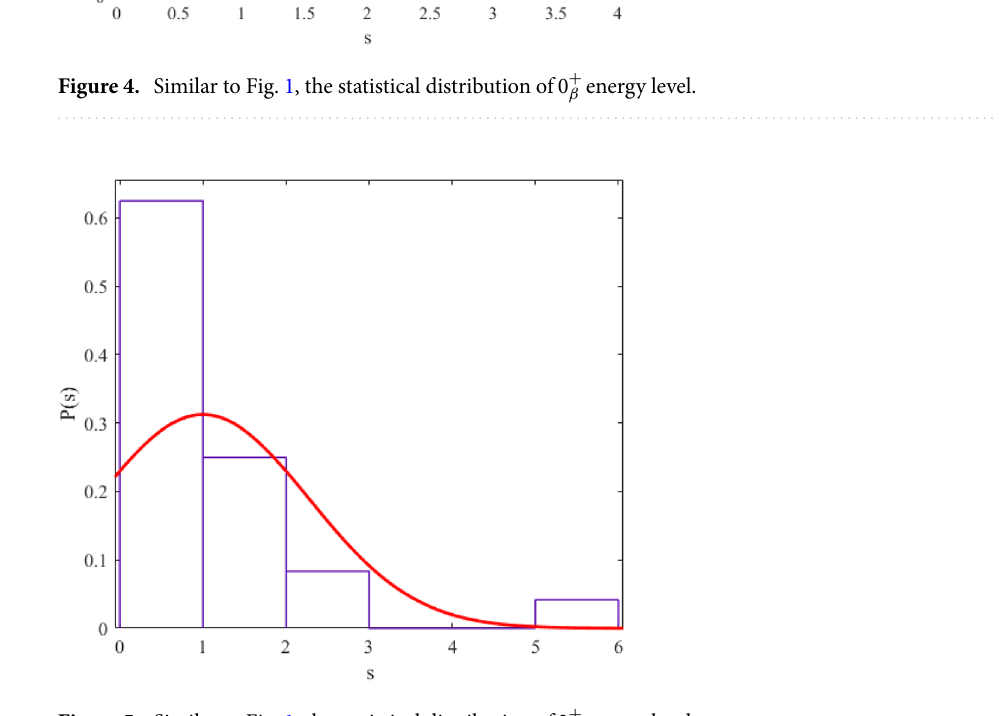
Figure 5. Similar to Fig. 1, the statistical distribution of 2